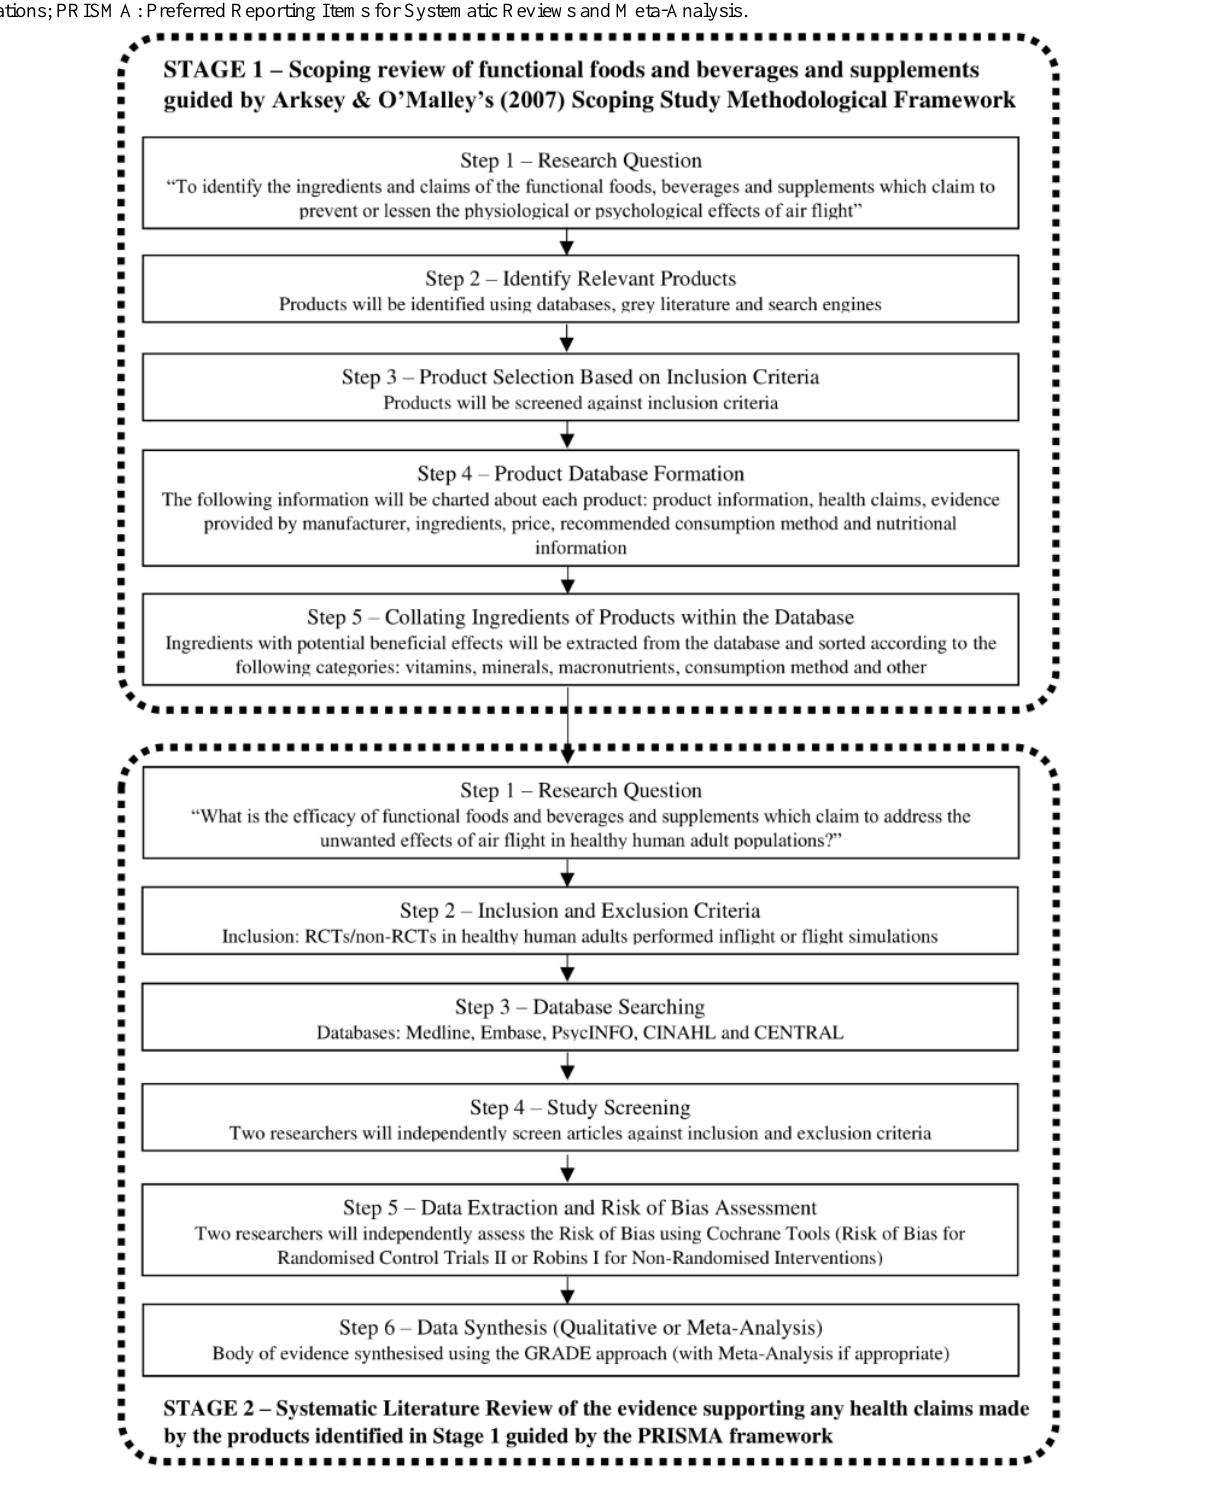
Figure 1. Flow diagram of study design. RCT: randomized controlled trial; GRADE: Grading of Recommendations, Assessment, Development and Evaluations; PRISMA: Preferred Reporting Items for Systematic Reviews and